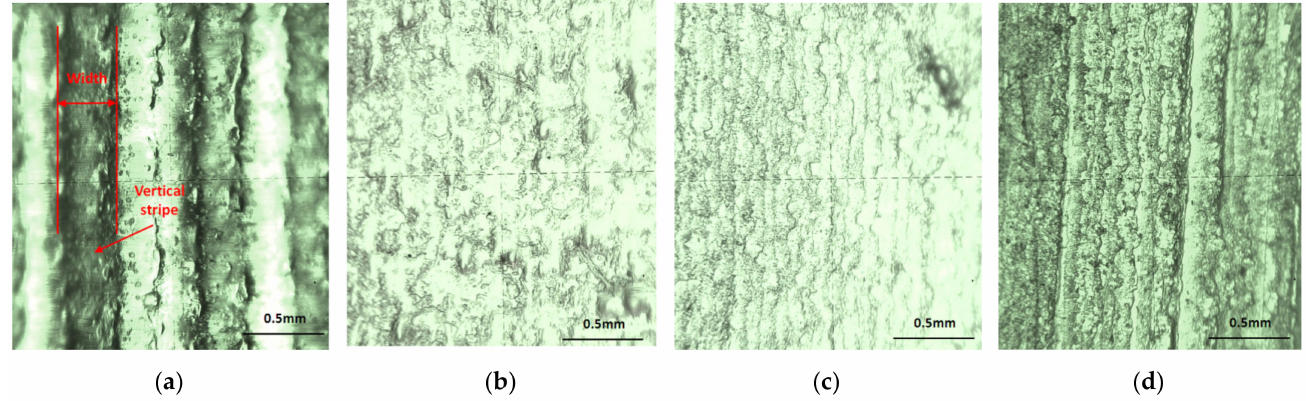
Figure 18. The texture of the airfoil surface: ( a ) glossy XY; ( b ) glossy YX; ( c ) matte XY; ( d ) matte YX. Semi-transparent surfaces were detected for the specimens printed in glossy mode. The lateral shape of the airfoils was analyzed, especially on the leading edge and the trailing edge of the airfoil (Figures 19 and 20). A rounded edge was detected around the airfoil curve. This is represented by a black border (Figure 19a,b and Figure 20a,b) in the case of glossy type. In addition, the edges of the airfoils printed in matte mode are rounded, as shown in Figure 19c,d and Figure 20c,d.